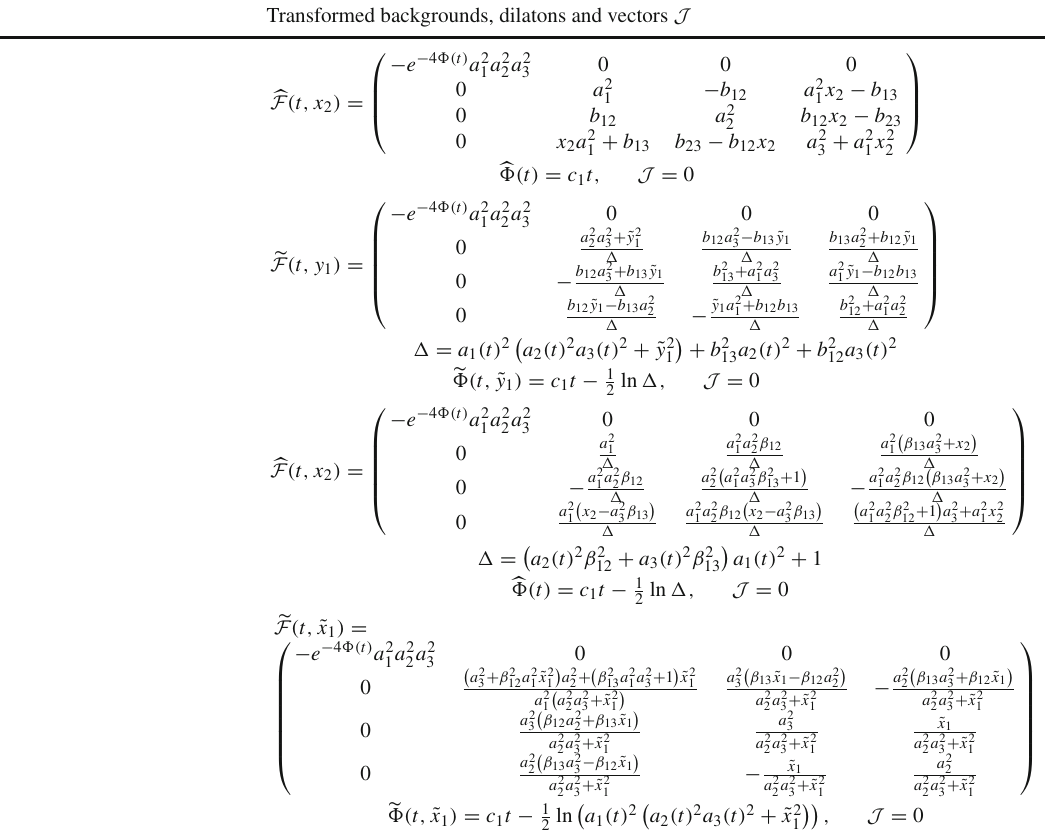
Table 2 Results for Poisson–Lie identities and dualities of Bianchi I I cosmology. Functions a i ( t ) are given by (53) and (cid:14)( t ) = c 1 t B II Transformed backgrounds, dilatons and vectors